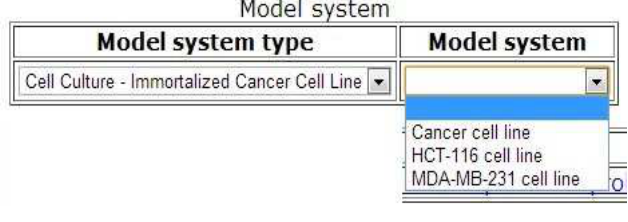
Figure 10. Model system restriction.